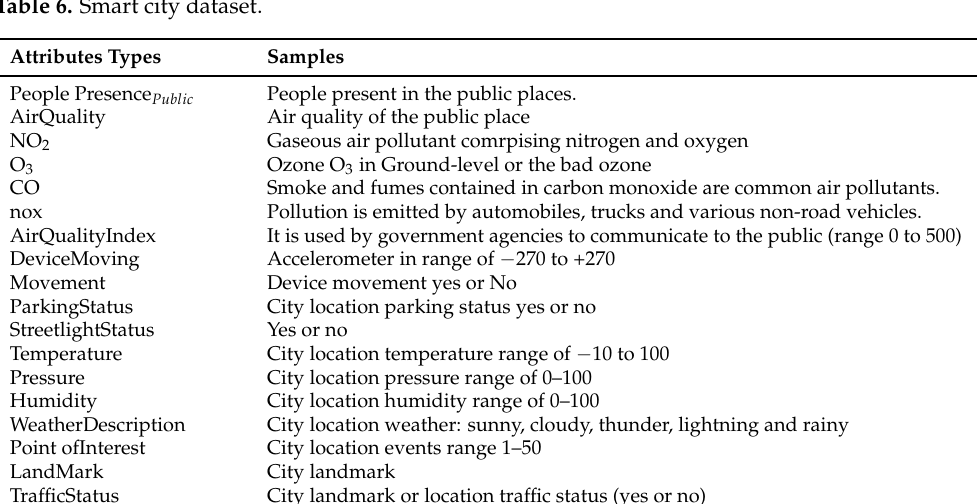
Table 6. Smart city